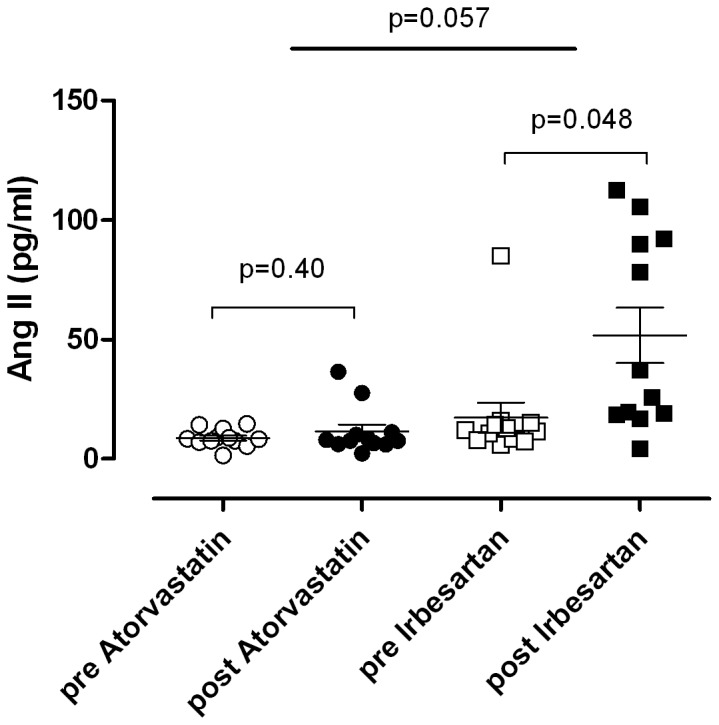
Atorvastatin and irbesartan influences on plasma concentrations of angiotensin II.Within-group differences were analyzed with Students paired t-test and between-group differences with a two-way ANOVA. Data are expressed as individual values and as mean ± SEM.